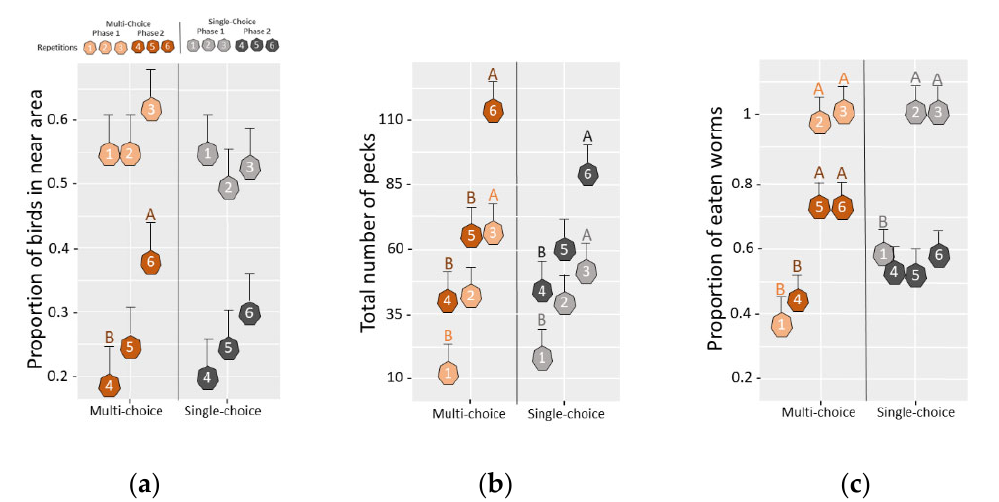
Figure 5. The response dynamics in the repeated opportunity test. Dot plot (estimated marginal mean and SEM) showing the response dynamics with each repetition during the repeated opportunity test for chicks from the “multi ‐ choice” and “single ‐ choice” treatments, regarding ( a ) the proportion of chicks located in the near area (the area where the ground food bowl was located for repetitions 1–3 and where both food bowls and the test person were located in repetitions 4–6), ( b ) the total number of pecks to feed bowl(s), and ( c ) the proportion of worms eaten during each repetition. Different letters (A,B; note also the different shades within each color) indicate significant differences between repetitions within treatments and phases.